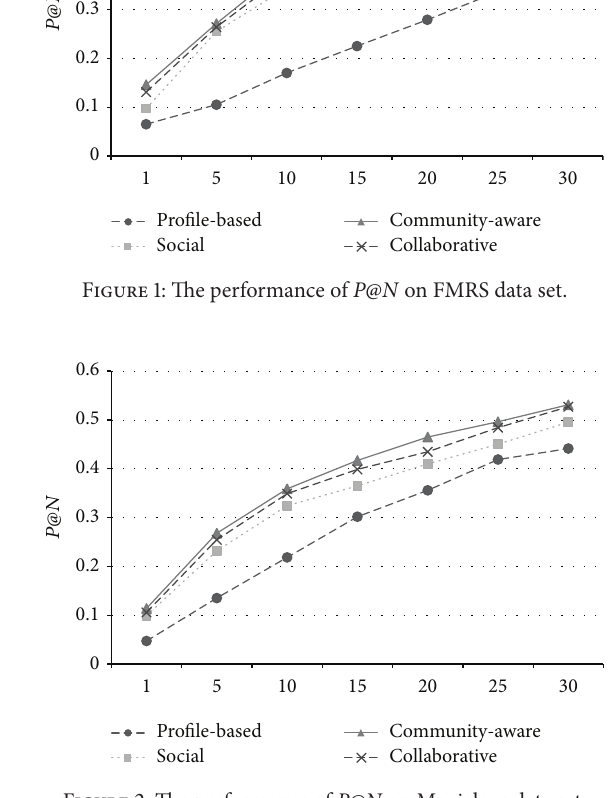
Figure 2: The performance of P@N on Movielens data set. Table 2: The performance of MRR on FMRS and Movielens data